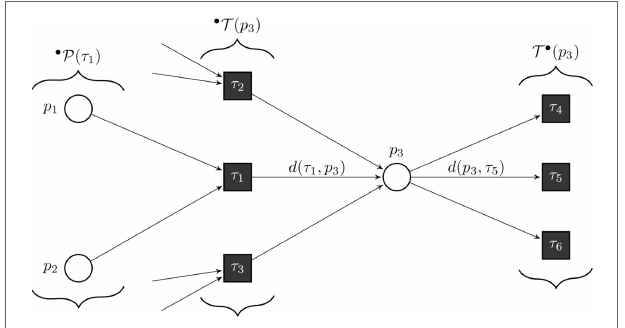
FIGURE 8 | Formal definition of a continuous Petri net (CPN). Our model is a CPN. CPNs can be represented equivalently by ordinary differential equations and, thus, inherit dynamical behavior. The exemplary CPN shows our notation: ° T ( p ) is the set of all incoming transitions of place p . T °( p ) is the set of all outgoing transitions of place p . ° P ( τ ) is the set of all places with an edge directed to transition τ . With this notation, we define the transition functions ∑ ∑ by @ y ( p ) @ t = d ( τ ; p ) v ( T ) (cid:0) d ( p ; T ) v ( T ) . In the case of τ ∈•T ( p ) τ ∈T• ( p ) general mass action kinetics ( 38), the transitions are given by v ( T ) = x ( T ) (cid:1)